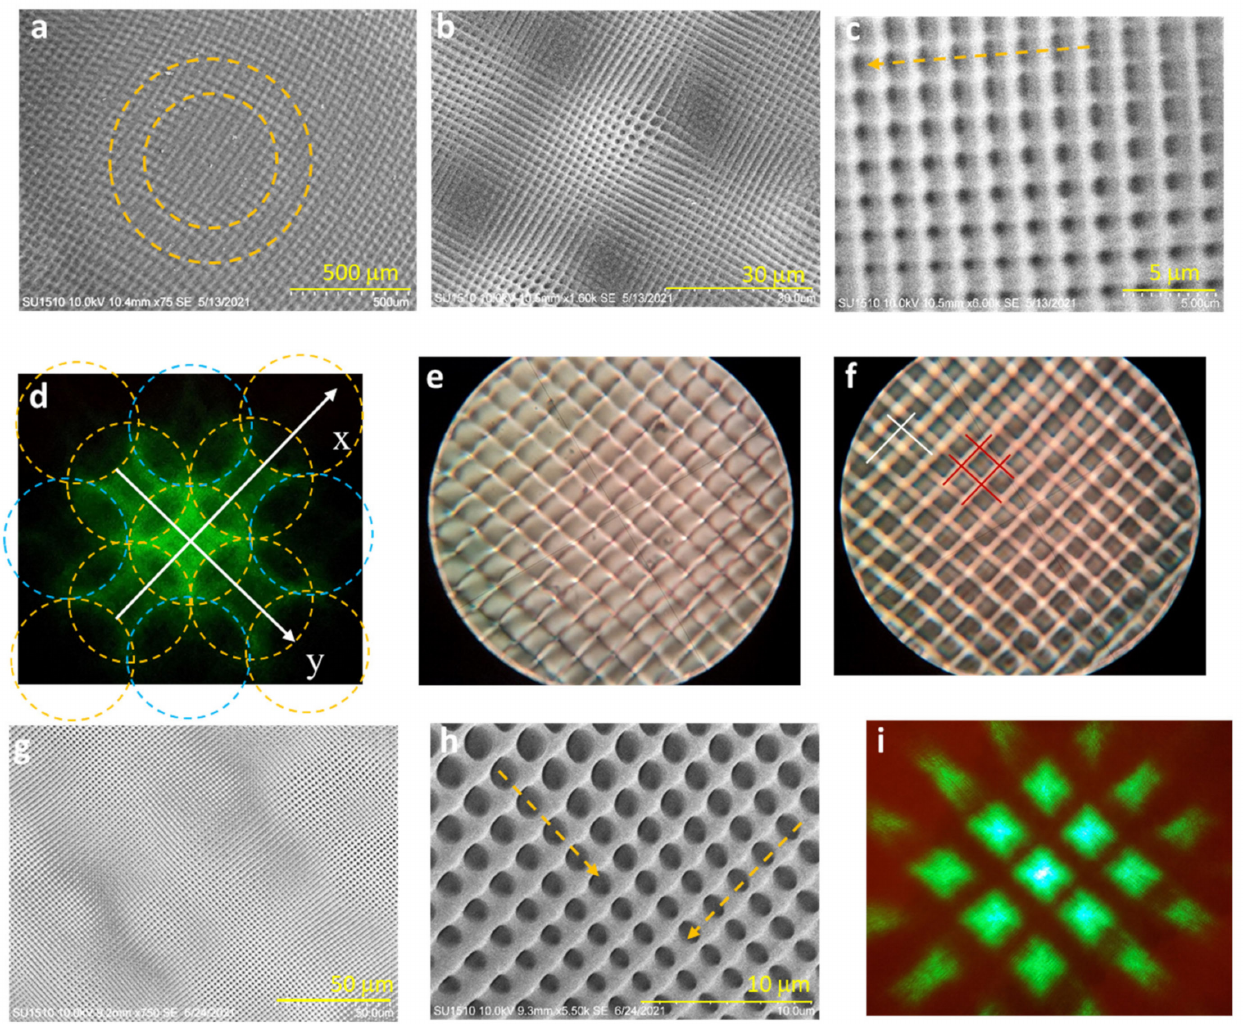
Figure 2. ( a ) SEM image of type-1 over-exposed sample with the dashed yellow circles for the eye-guidance of Fresnel pattern, and its enlarged view in ( b , c ). ( d ) A diffraction pattern from the sample in ( a ) showing 0th order and 1st order diffraction zones. ( e , f ) Optical images displaying the Talbot diffraction pattern close to and farther away from the sample, respectively. ( g ) SEM image of well-developed type-1 3D GPSC and its enlarged view in ( h ). ( i ) Diffraction pattern of well-developed GPSC with 3 × 3 diffraction